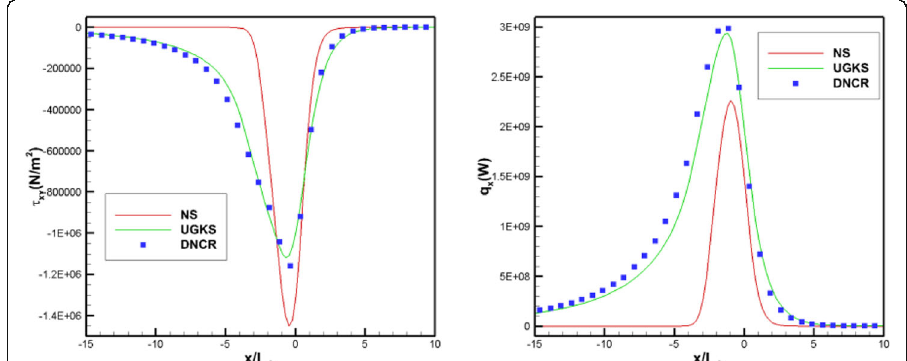
Fig. 5 Comparisons of stress τ xx and heat flux q x in shock structure using the NS, UGKS and DNCR at Mach 8